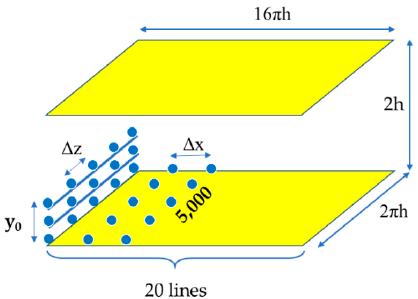
Figure 1. Channel geometry and points of release of markers at time t = 0.